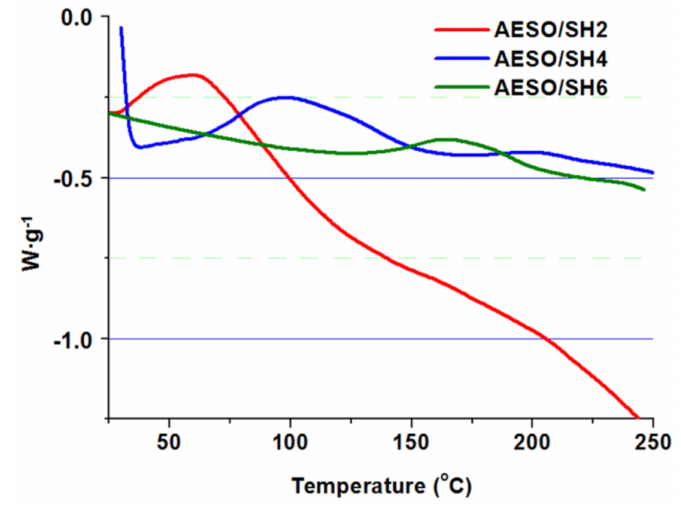
Figure 2. Calorimetric curves of the curing of AESO with different thiols with 1 phr of 1MI recorded at 10 ◦ C · min − 1